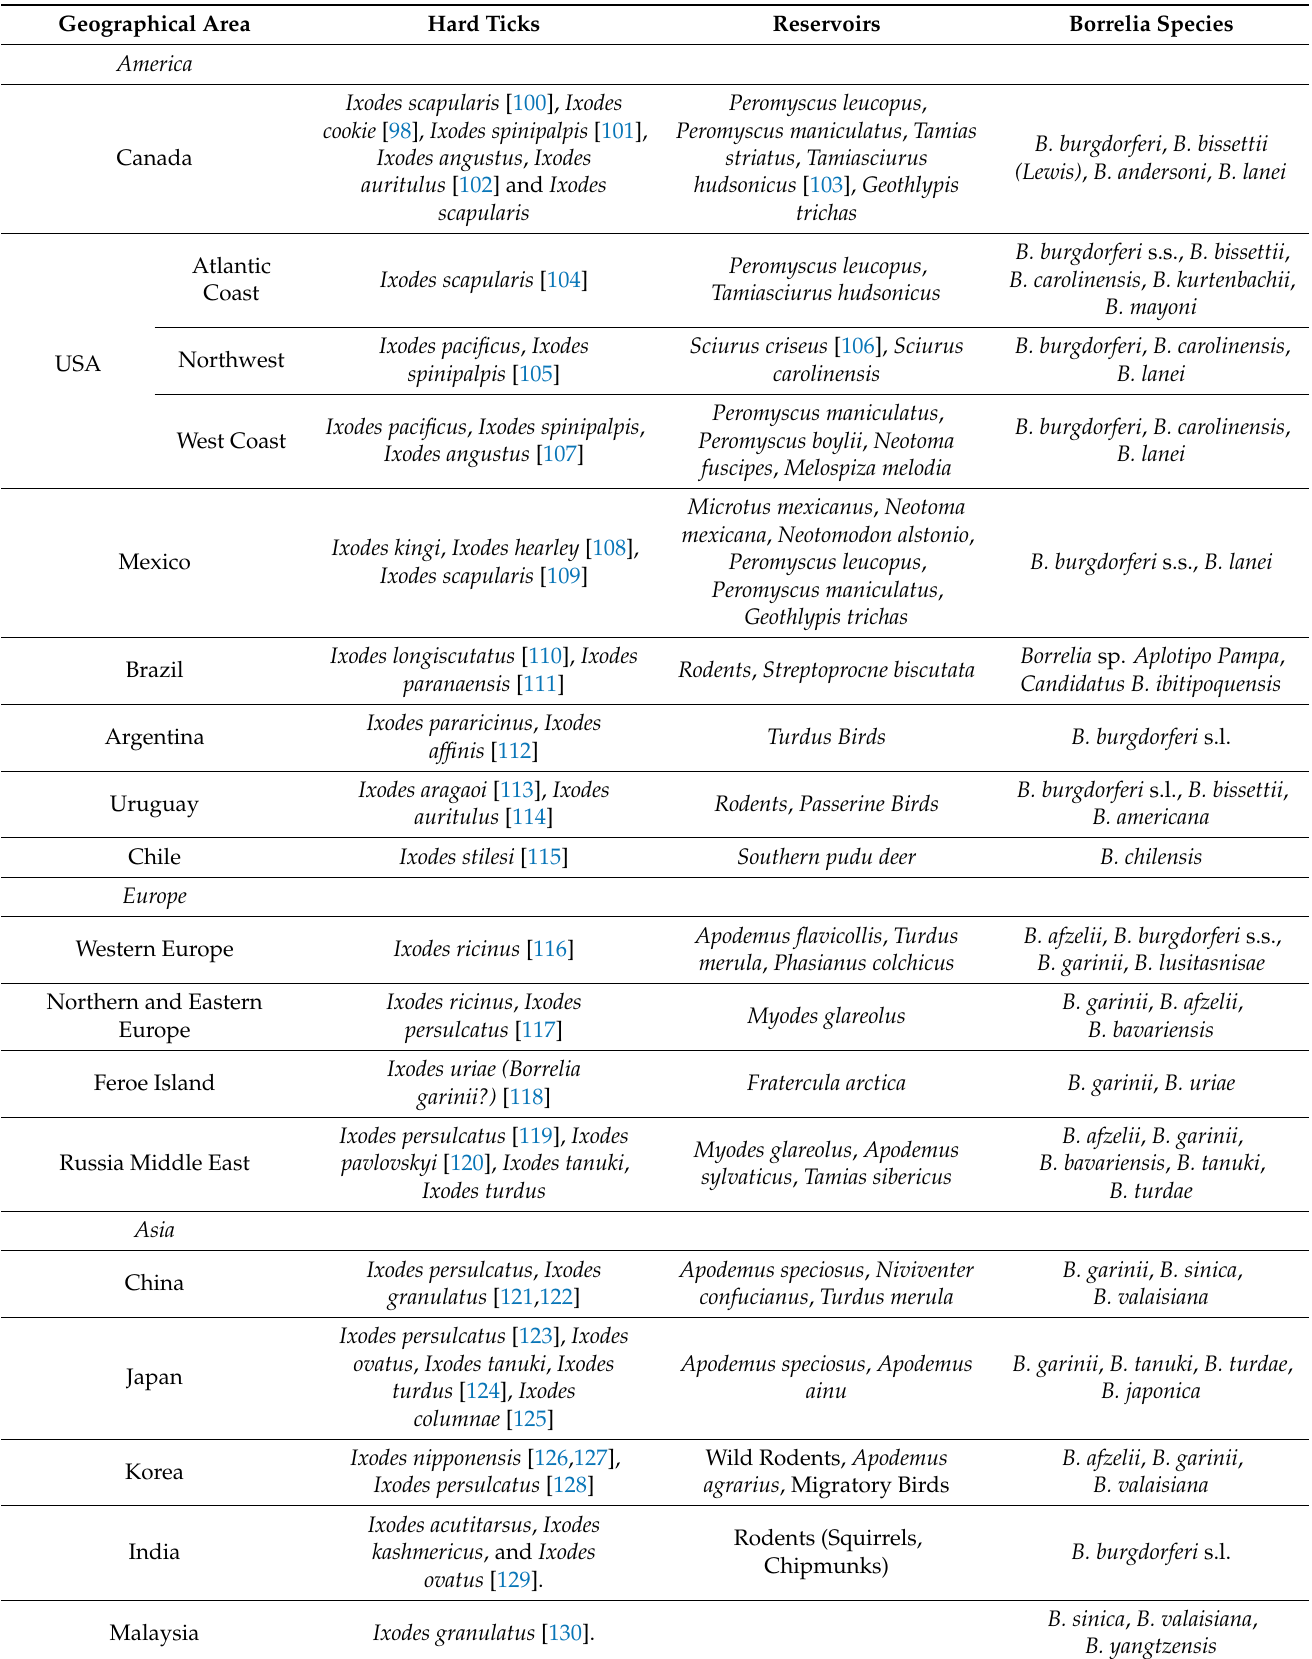
Table 4. Distribution of hard ticks Borrelia LG vectors, reservoirs and Borrelia species worldwide. Geographical Area Hard Ticks Reservoirs Borrelia